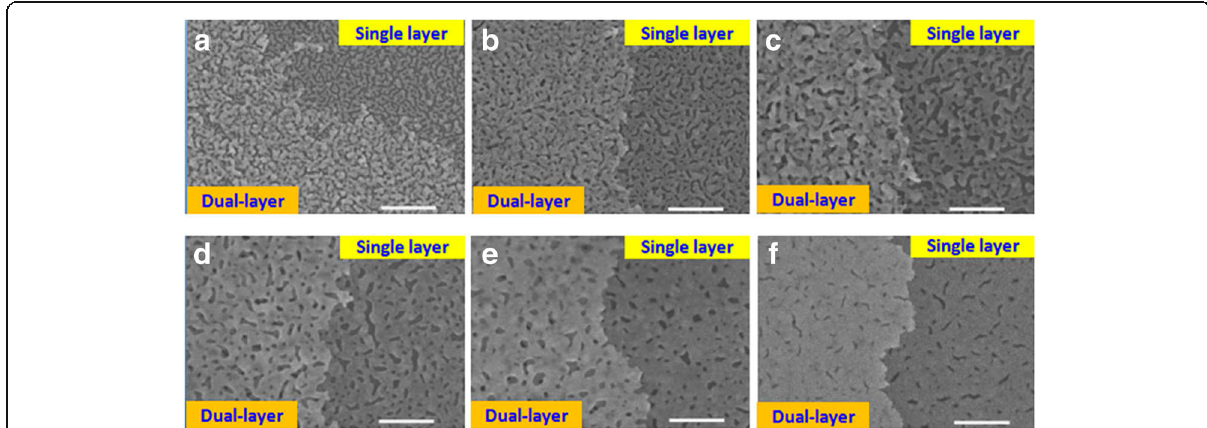
Fig. 1 SEM images taken from the boundaries of the fabricated samples where the single- and dual-layer porous Au film structures can be clearly observed. The sputtering time of each layer of porous Au films changes from 19 to 75 s. a 19 s, b 28 s, c 37.5 s, d 47 s, e 56 s, and f 75 s. Annealing temperature: 200 °C. Scale bar is 500 nm